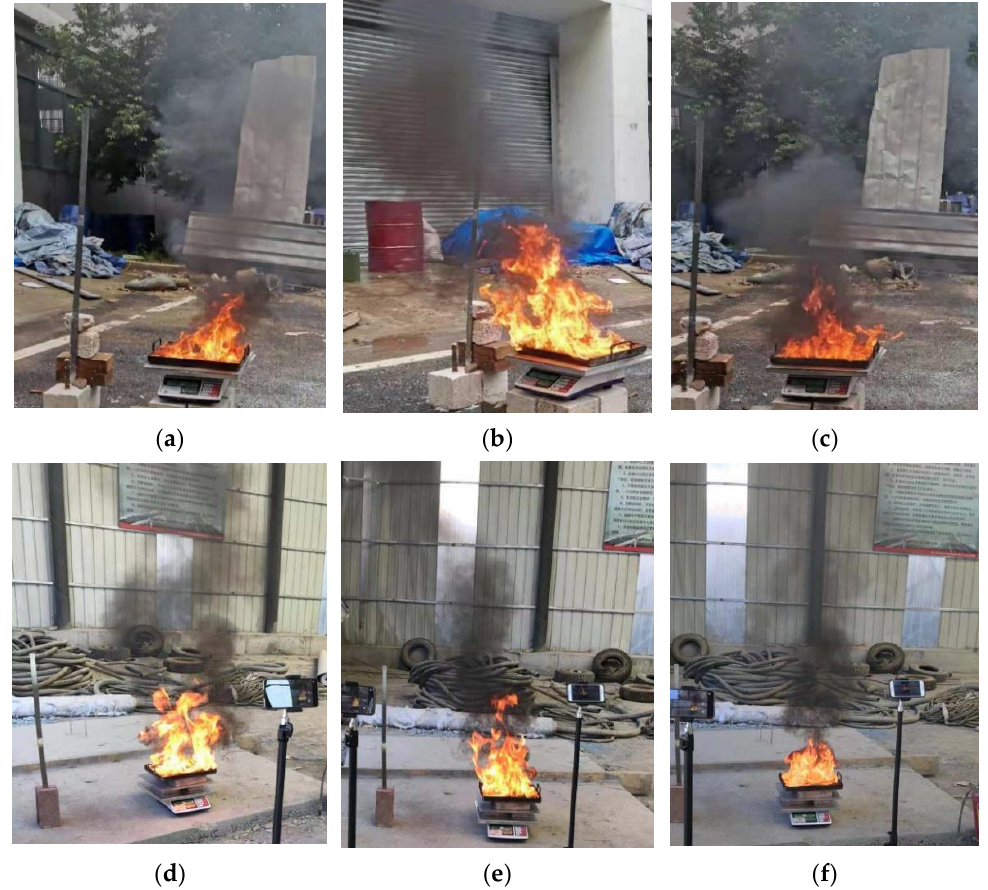
Figure 7. Smoke release rate in experimental sites. ( a ) Initial stage in Sichuan; ( b ) Stable stage in Sichuan; ( c ) Attenuation stage in Sichuan; ( d ) Initial stage in Tibet; ( e ) Stable stage in Tibet; ( f ) At- tenuation stage in